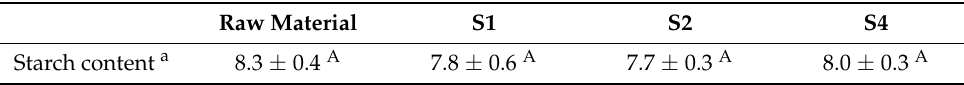
Table A3. Starch contents (g/100 g dm, mean value ± standard deviation, n = 3) of enzymatically treated apple pomace (raw and extruded). S1: only transport elements, S2: two reverse elements, S4: two reverse elements and a kneading block.